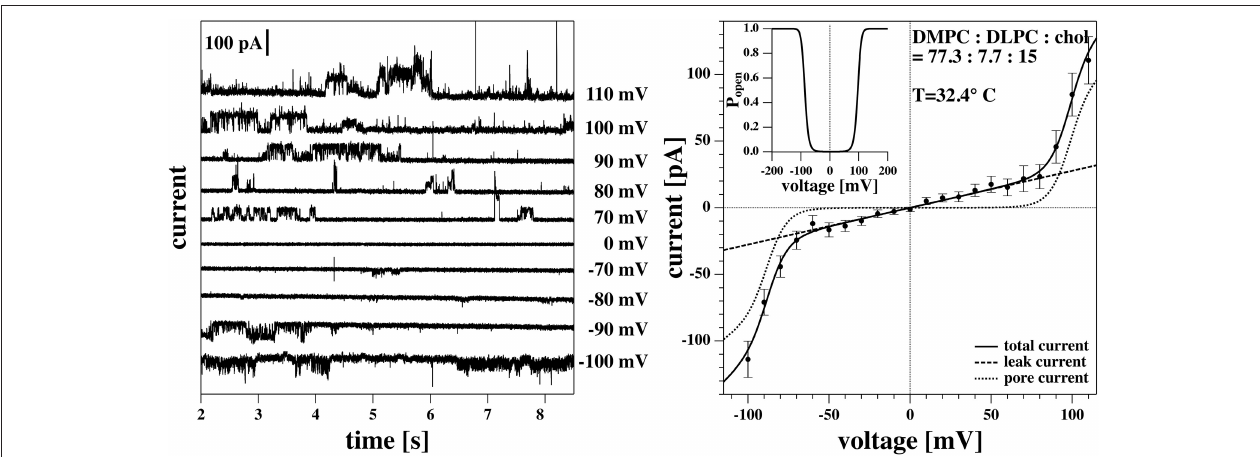
FIGURE 11 | Recordings on a DMPC:DLPC:chol. = 77.3:7.7:15 BLM measured at 32.4 ◦ C. (Left) Current traces. For better visibility, they are evenly spaced on the vertical axis. Note, the current traces in the linear regime of the I-V profile are not shown. (Right) I-V-profile. The solid line is a fit of the I-V profile to Equation (5). The insert represents the pore open probability. Note that for the BLM, the I-V profile is symmetric and the channel activity occurs at both higher positive and higher negative voltages.